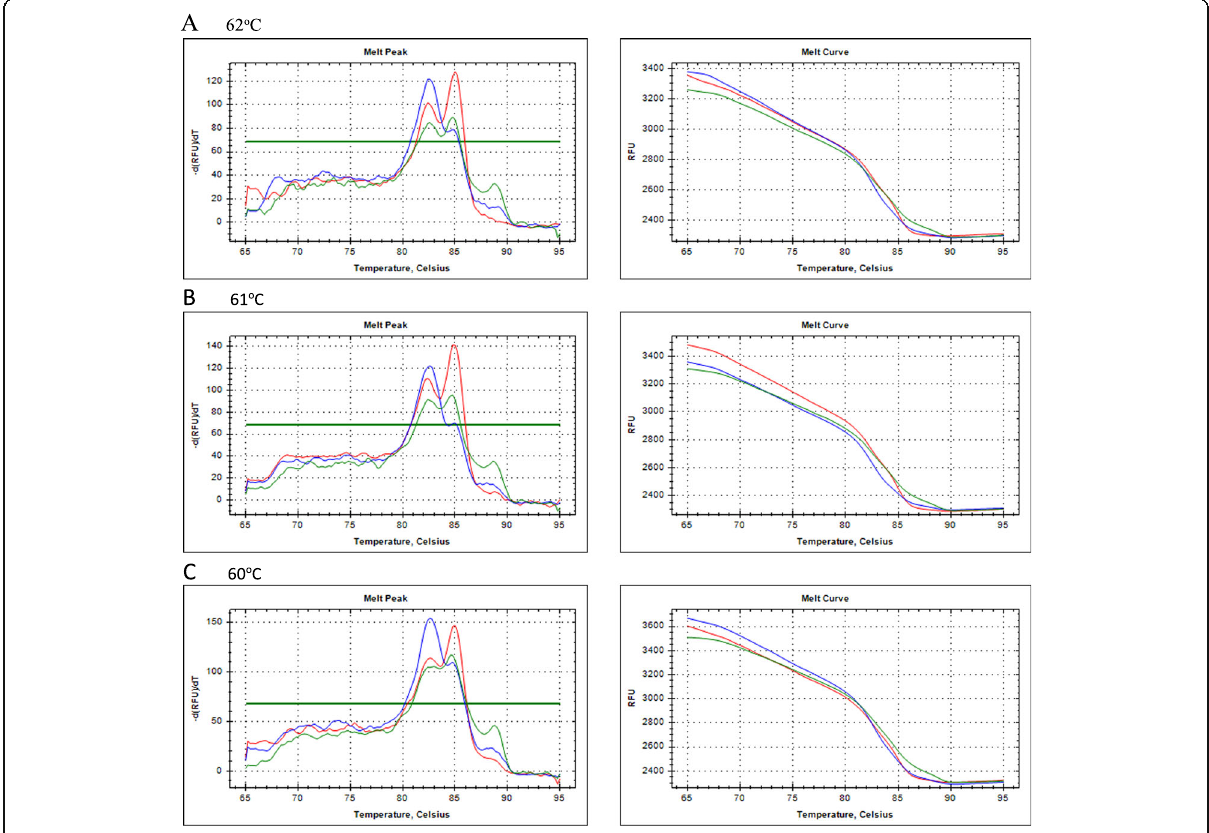
Fig. 1 Melting curve and melting peak at 62 °C, 61 °C, and 60 °C annealing temperature (AA: blue, AG: green, GG: